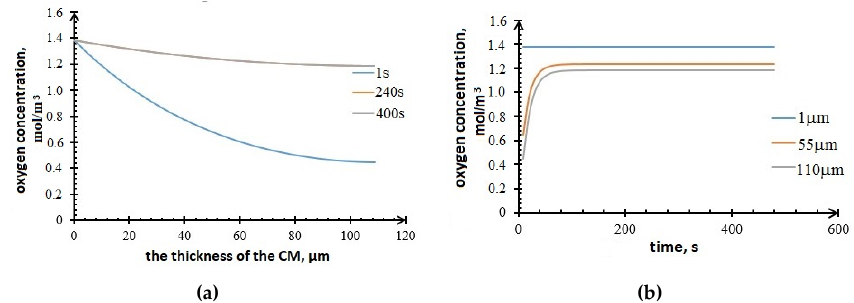
Figure 11. Profiles of oxygen concentration in the cathode ( a ) vs. CM thickness; ( b ) vs. time.